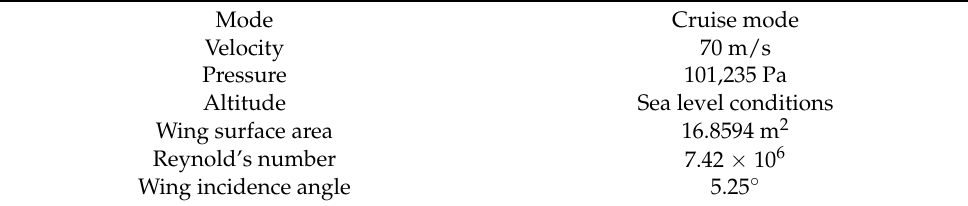
Table 12. Boundary conditions for lift coefficient calculations.